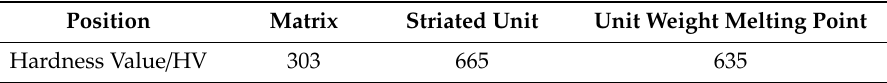
Table 3. The hardness value.